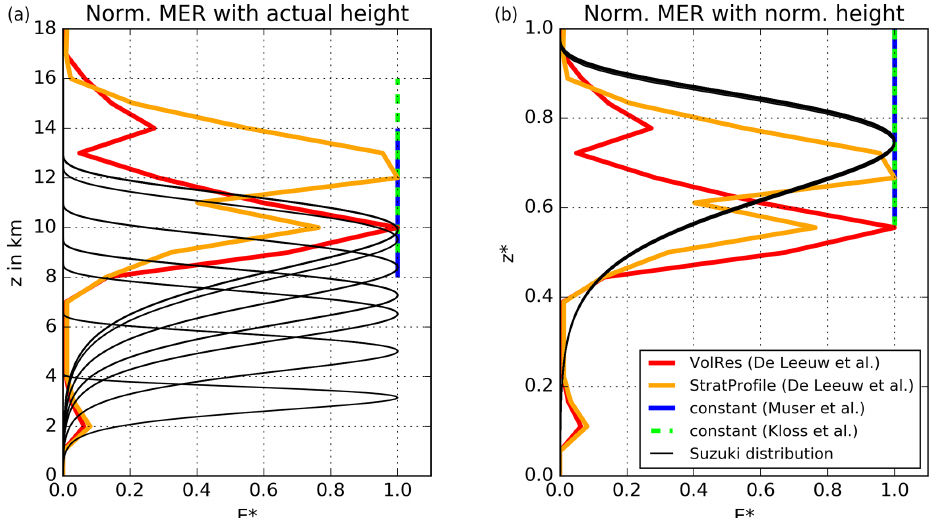
Figure A1. Comparison of the Suzuki profiles used in this work with vertical emission profiles from previous studies (“VolRes” and “StratProfile” from De Leeuw et al., 2021, and constant profiles from Muser et al., 2020, and Kloss et al., 2021). (a) Normalized with respect to the MER ( E ∗ ) but with actual emission heights ( z ). (b) Normalized with respect to the MER and emission height ( z ∗ ).